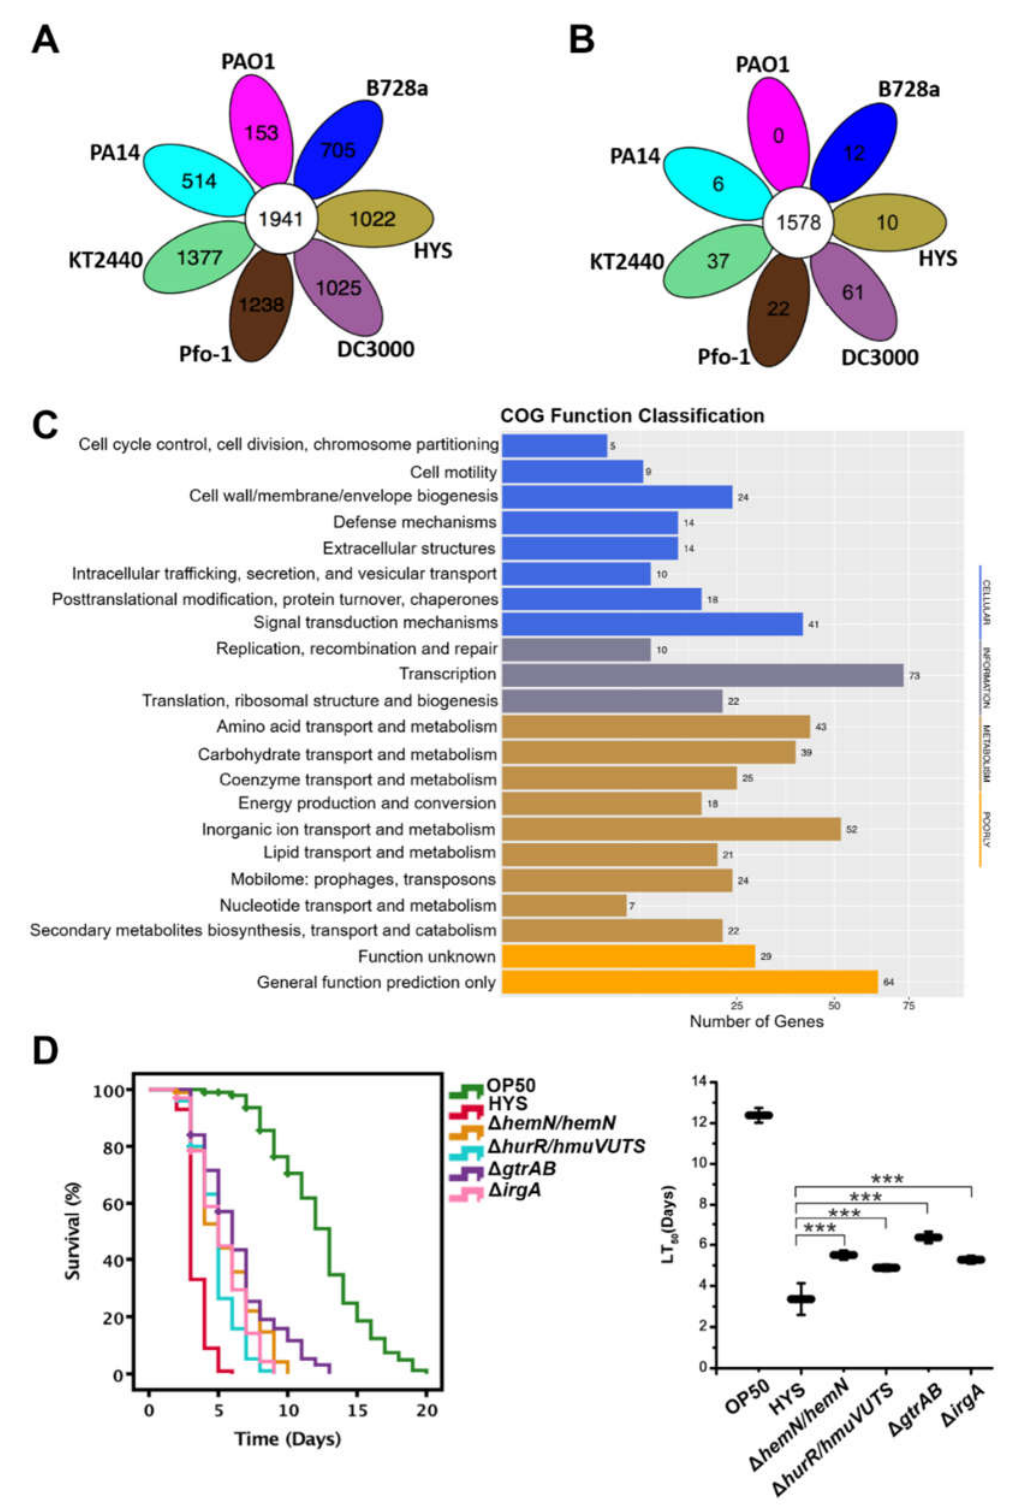
Figure 1. UpSet plots of pan gene set and the number of homologous gene families in each species. ( A ) UpSet plot of pan gene set among seven strains. ( B ) UpSet plot of the number of homologous gene families among seven strains. Each